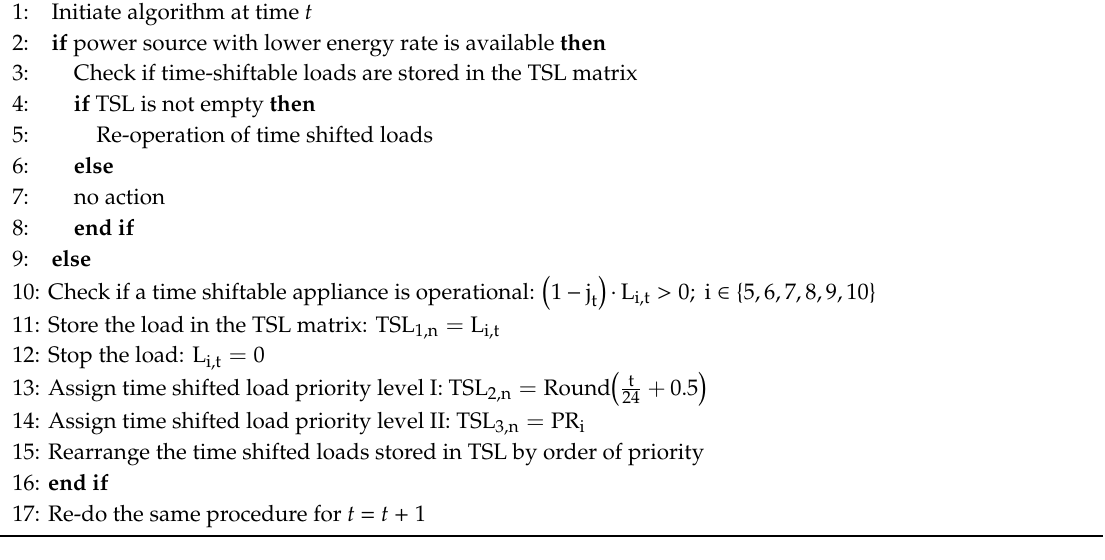
Algorithm 1: Demand Response Optimization of Time Shiftable Loads